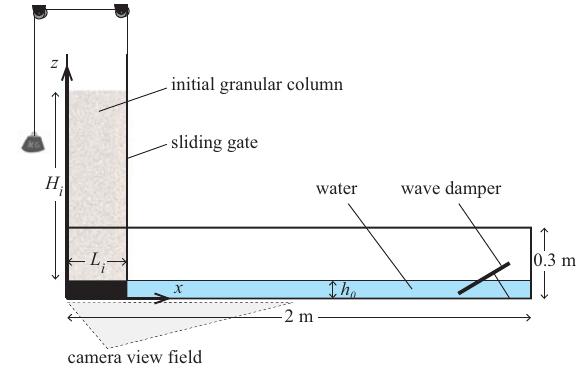
Figure 1. Schematic of the experimental